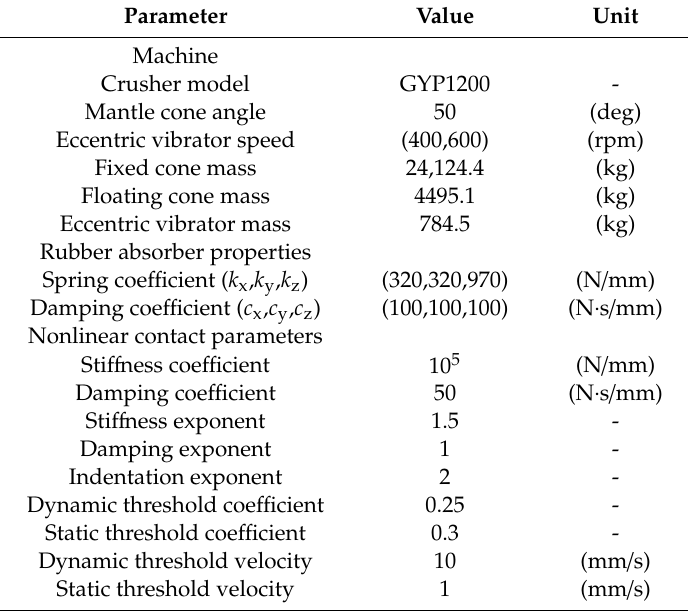
Table 1. Parameters for the RecurDyn